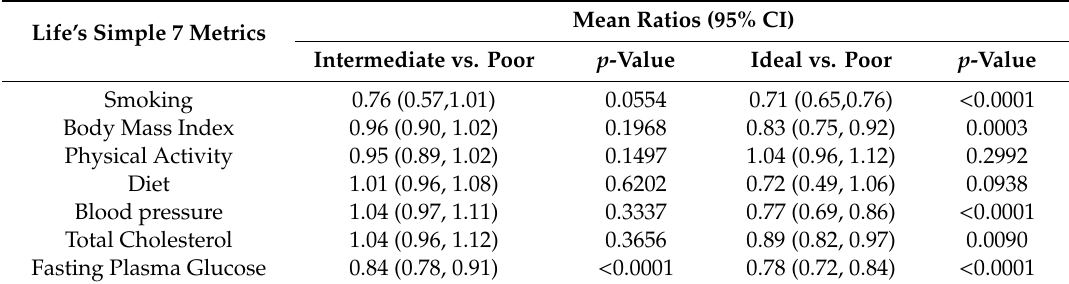
Table 4. Associations of individual Life’s Simple 7 metrics with